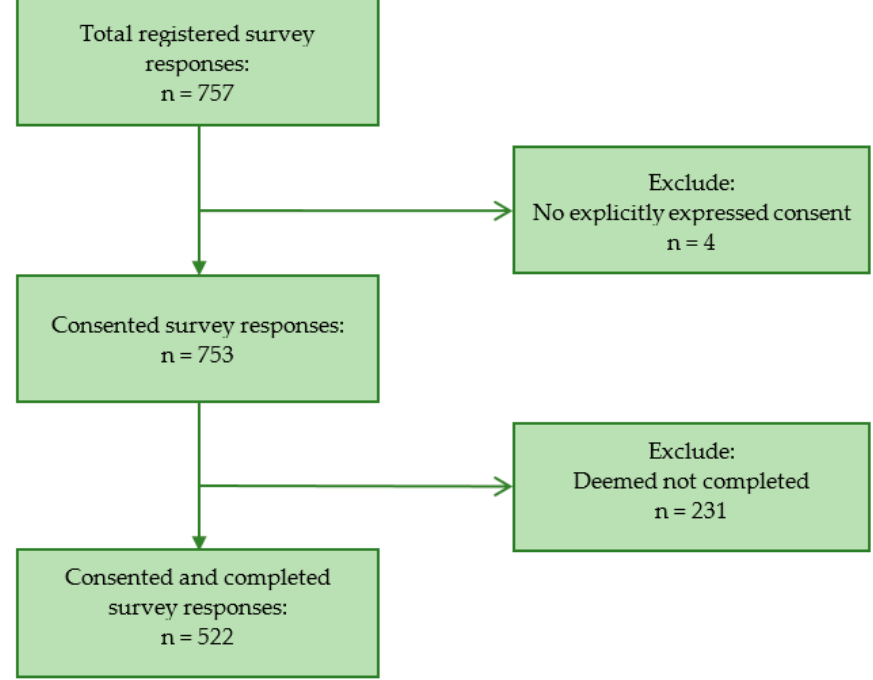
Figure 1. Filtering the survey responses for analysis.